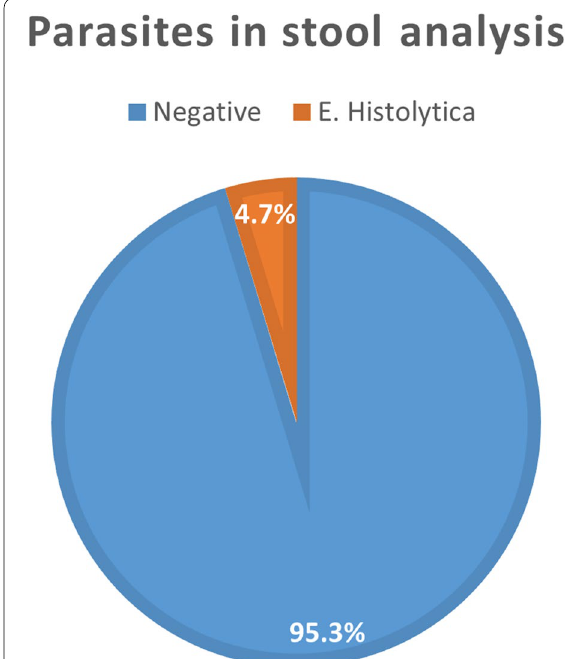
Fig. 3 Percentage of the patients with parasites in their stool analysis